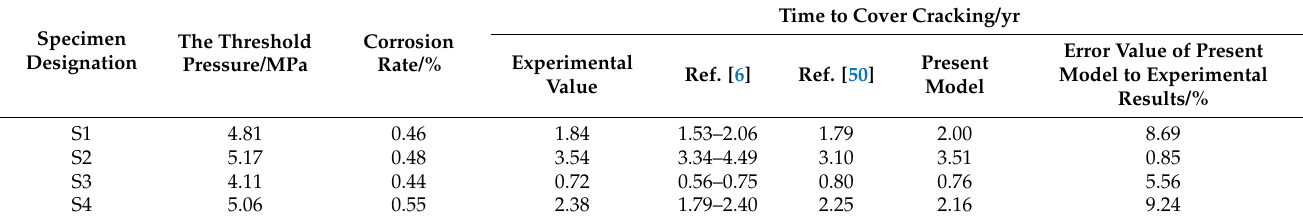
Table 2. Results comparison of present model with experimental prediction and other models. Specimen